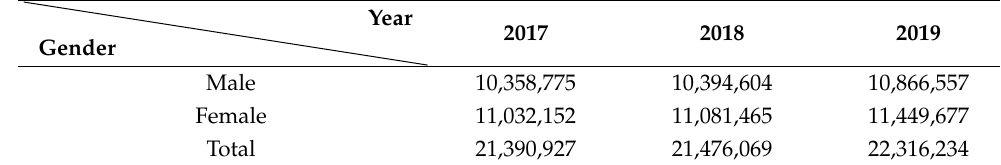
Table 1. Statistics on number of hospital visits from 2017 to 2019 (Unit: person) [6].